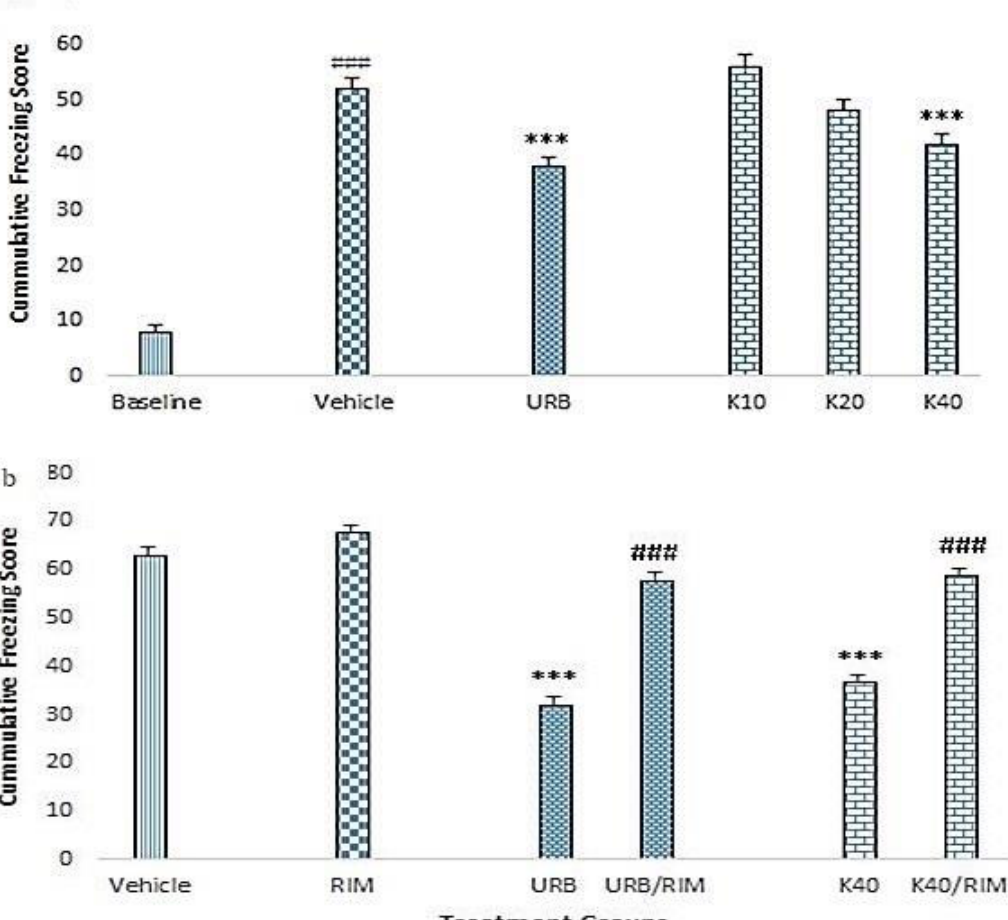
Figure 2. E ff ect of kaempferol on the cumulative freezing scores of fear-conditioned rats. Rats were acclimatized for three days and baseline-freezing behavior was recorded by placing the rats in a fear- conditioning cage. ( a ) Depiction of the freezing score in the presence of various treatments, i.e., vehicle, (URB597 1 mg / kg) and kaempferol (K10, 20 or 40 mg / kg). The *** indicate p < 0.001 as compared to vehicle control. The ### shows p < 0.001 as compared to baseline. ( b ) Depiction of the e ff ect various treatments in the presence of rimonabant (RIM, a CB1 receptor antagonist, 1 mg / kg). The freezing scores during extinction sessions were compared among various treatment groups. *** p < 0.001 as compared to vehicle. ### p < 0.001 as compared to respective control (URB or K40 alone) without RIM. Data are shown as the mean ± S.E.M of cumulative freezing of rats for five days.